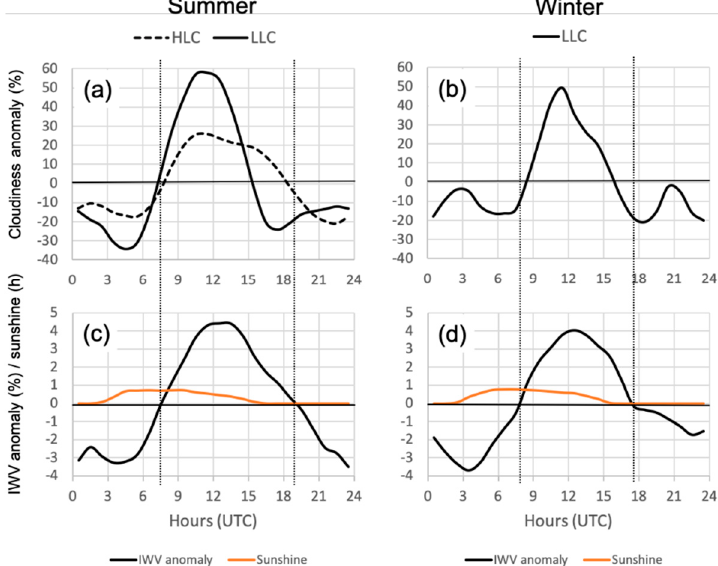
Figure 10. Diurnal cycle of high level (HLC) and low-level (LLC) clouds, Integrated water vapour (IWV) and insolation at Saint-Denis in 2018. Top panel: low-(1–3 km, plain) and mid-(5–10 km, dashed) level cloud anomaly (%) during ( a ) summer 2018 and ( b ) winter 2018. Bottom panel: Diurnal cycles of GNSS-derived (STDE station) IWV anomaly (%, black) and insolation (hours, orange) during ( c ) summer 2018 and ( d ) winter 2018.